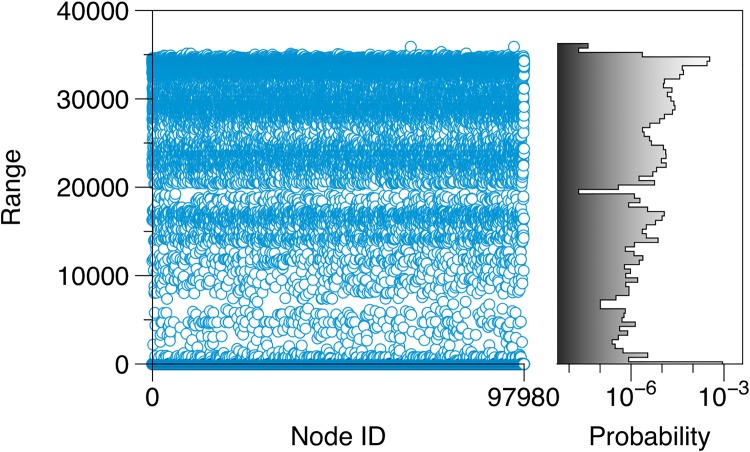
Range for every node in the temporal network.The right panel shows the histogram of the y-axis values on a log scale. In contrast to the static case (see Fig 4) the values cover the whole spectrum from minimum to maximum range.